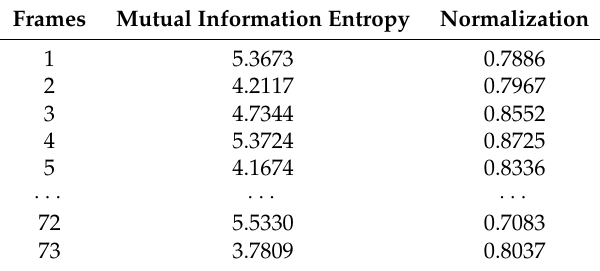
Table 1. Mutual information entropies and their normalizations for the two adjacent frames.